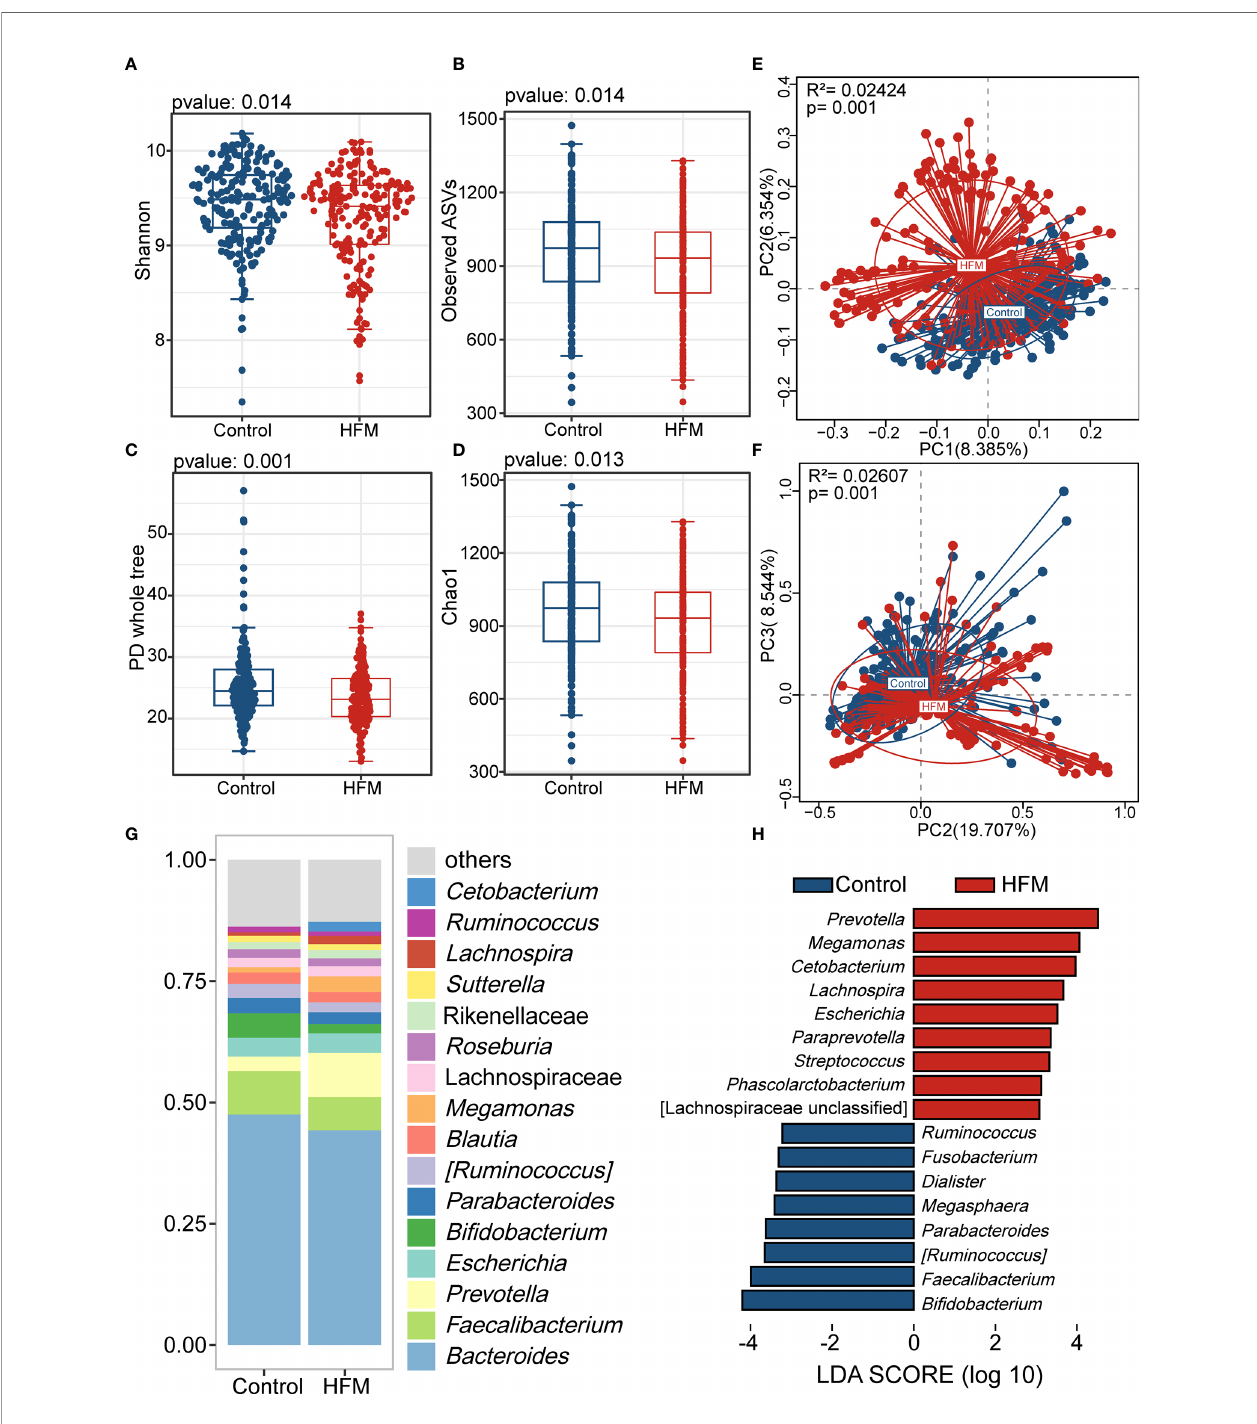
FIGURE 2 | Altered bacterial microbiota biodiversity and composition in HFMD based on cohort matched age and sex. (A – D) Alpha diversity. Comparison of alpha-diversity indices (Shannon, observed ASVs, PD whole tree and Chao 1 index) between the HFMD and control groups (Wilcoxon rank-sum tests). (E, F) Principal coordinate analysis based on unweighted and weighted UniFrac distances revealed that the bacterial communities of patients with HFMD clustered separately from the bacterial communities of healthy control children. Each point represents a single sample, which is colored based on the group. PC1, PC2 and PC3 represent the top three principal coordinates that captured most of the diversity. The explanation of diversity captured by the coordinate is given as a percentage. (G) Relative abundance of the bacterial microbiota at the genus level. (H) Differences in the bacterial taxon abundance between patients with HMFD and control children by using Linear discriminant analysis effect size (LEfSe) analysis. HFMD-enriched taxa are indicated with a positive LDA score, and taxa enriched in healthy controls have a negative score. Only taxa meeting an LDA signi fi cance threshold of >3 are shown. LDA, linear discriminant